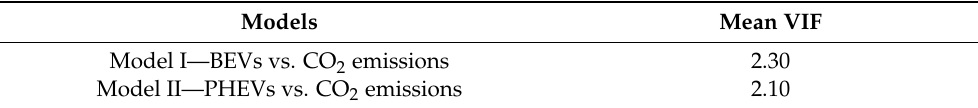
Table 4. VIF Test.